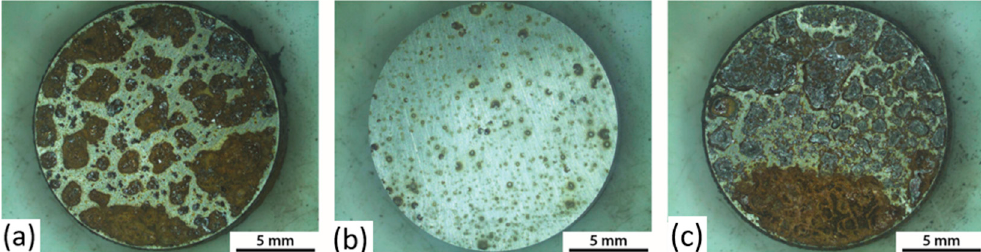
Figure 5. Representative samples after the condensation chamber exposure test; ( a ) Al-Mn type; ( b ) 6Al-4Mn steel; ( c ) Mn-Si type.